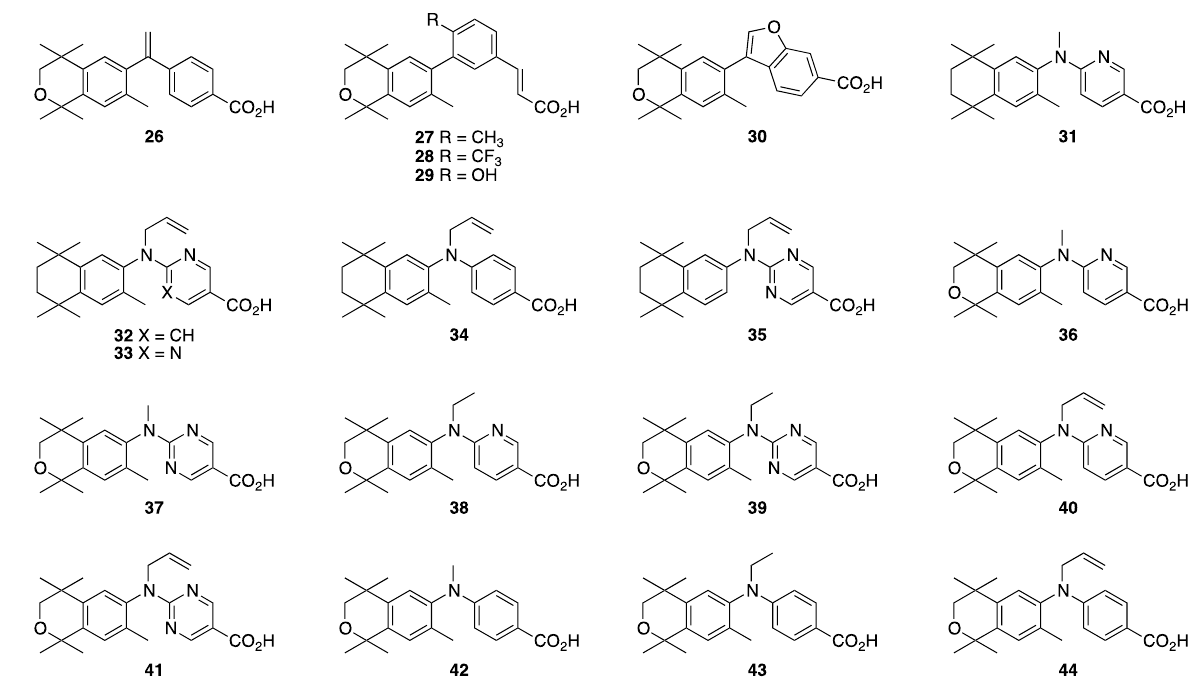
Figure 2. Structures of Reported Rexinoids 3–27 .